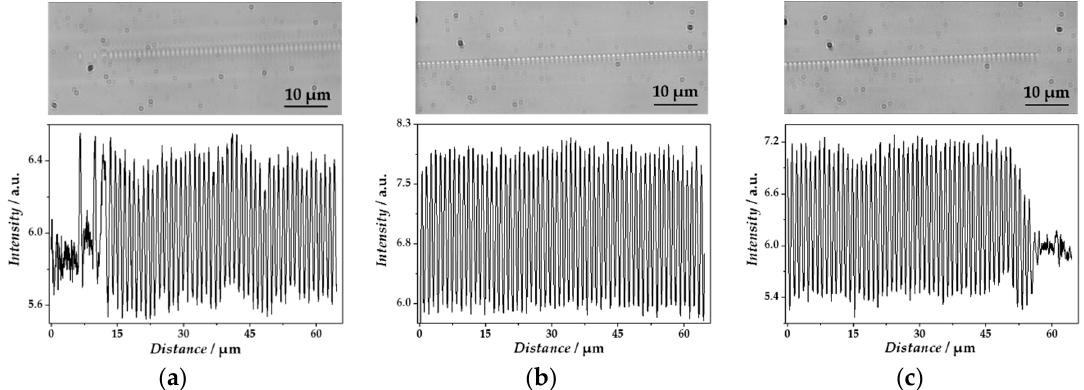
Figure 6. Microscopic images of a point ‐ by ‐ point written grating in the fiber core together with the corresponding intensity profile plots along the longitudinal fiber axis. ( a ) The starting region of the grating. ( b ) A middle ‐ section of the grating. ( c ) The end ‐ section of the grating.